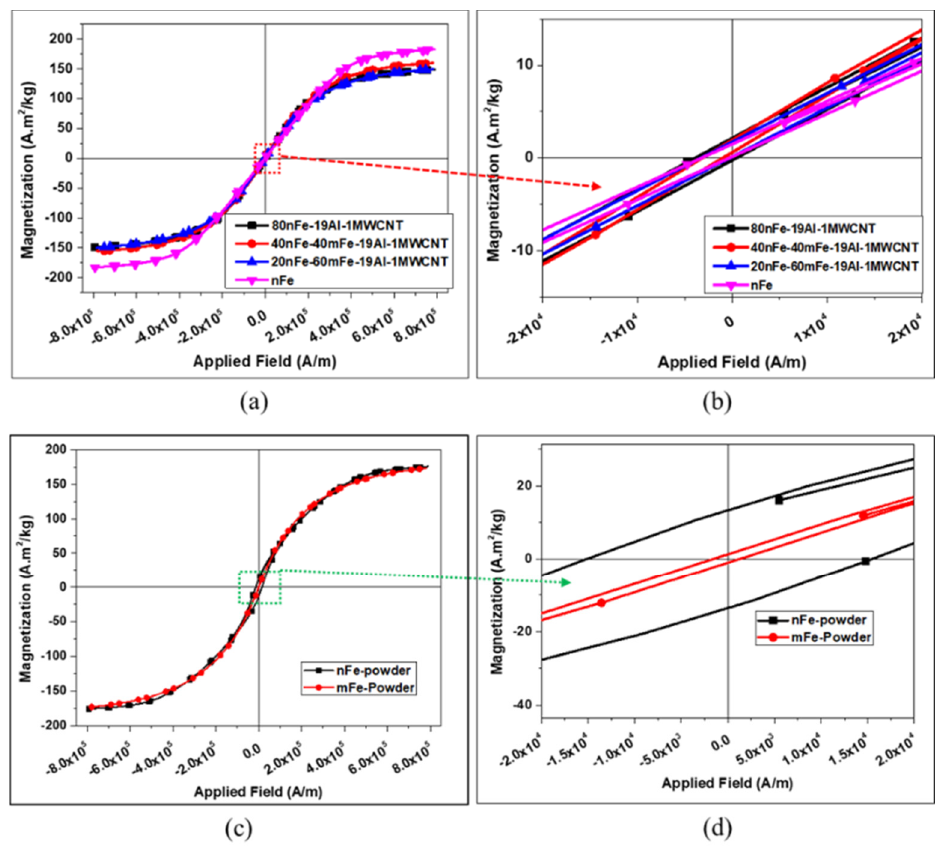
Figure 14. Comparative hysteresis loops of: ( a , b ) the nanocomposites according to Fe nanoparticles and Fe microparticles volume content and ( c , d ) the as-received Fe nanoparticles and Fe microparticles. Table 4. Density and magnetic properties according to nano-Fe and micro-Fe mixtures.